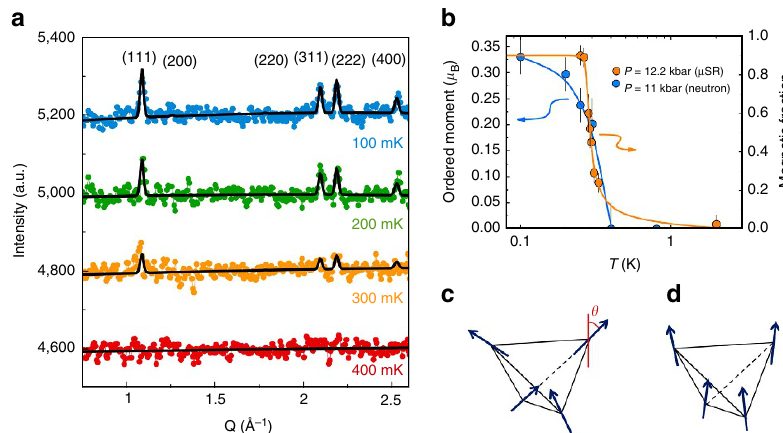
Figure 4 | Neutron diffraction measurements of Yb 2 Ti 2 O 7 under applied pressure. ( a ) Diffraction data sets from 400 to 100mK after the 800mK data set has been subtracted. Error bars are not shown for clarity. ( b ) Ordered moment versus temperature determined by neutron diffraction for P ¼ 11(2)kbar (blue, left axis) and magnetic fraction determined by m SR for P ¼ 12.2kbar (orange, right axis). Error bars of the ordered moment represent s.d. of the refinement. Schematic spin structure of the ice-like splayed ferromagnet with y ¼ 14 (cid:2) for P ¼ 0 ( c ) and y ¼ 5 (cid:2) for P ¼ 11kbar ( d ), where y is the splay angle between the [001] direction and the magnetic moment, tilted towards the local [111] directions of the